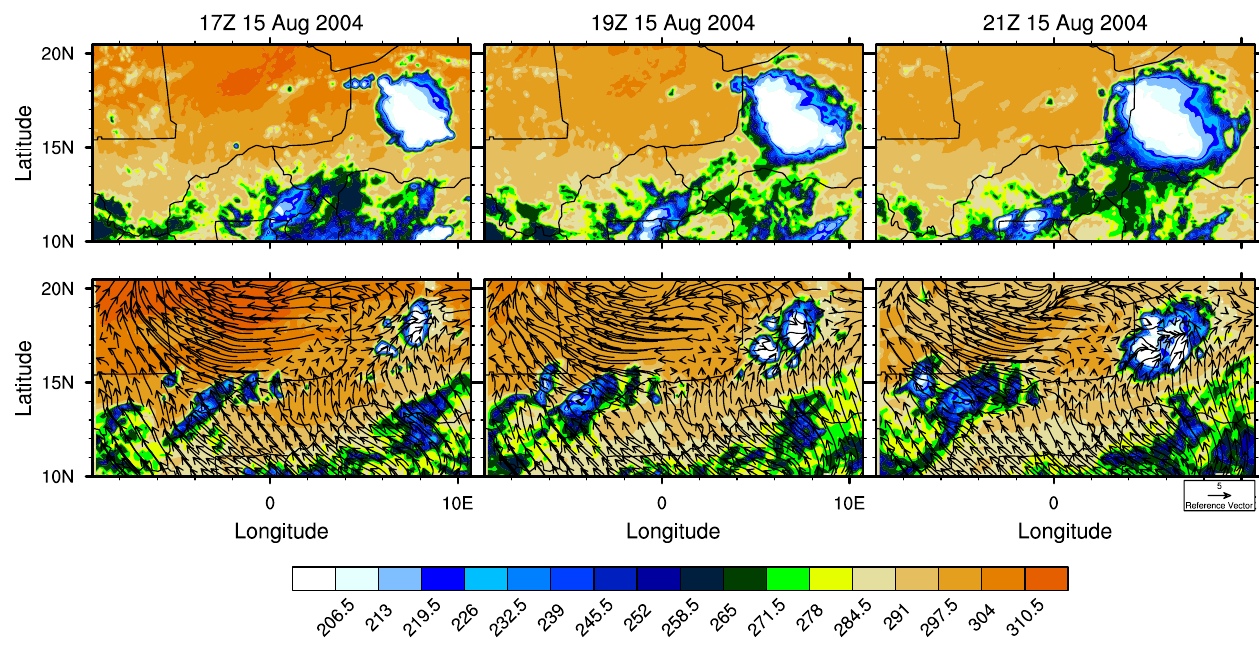
Fig. 5. Top: observed METEOSAT and bottom: simulated cloud-top infrared brightness temperature at 10.8µm for 15 August 2004 at 17:00, 19:00 and 21:00UTC. Horizontal wind fields simulated by Meso-NH and relative to the motion of the MCS are shown at 6km altitude.